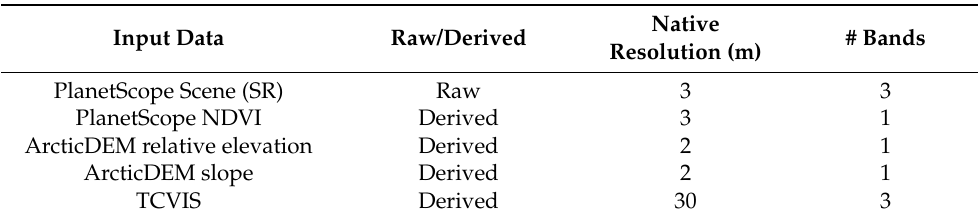
Table 3. List of model input data layers, with preprocessing status, native resolution and number of